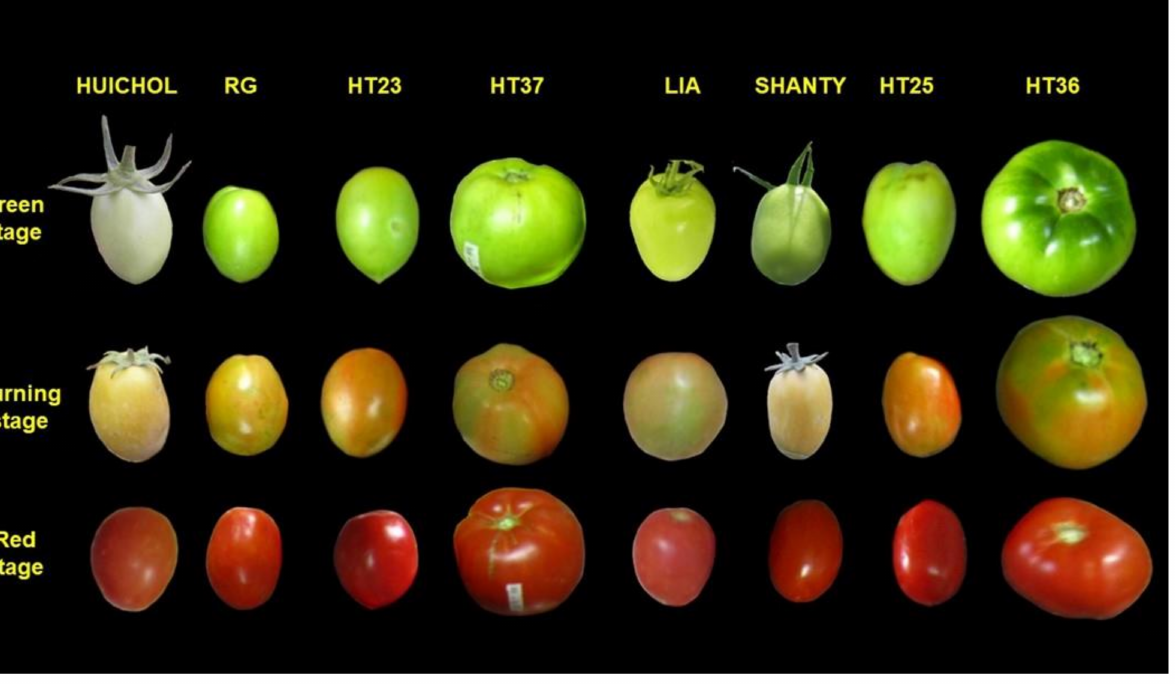
Figure 1. Tomato fruits of eight genotypes (From left to right: ‘Huichol’, ‘Rio Grande’ (RG), ‘HT23’, ‘HT37’, ‘Lia’, ‘Shanty’, ‘HT25’ and ‘HT36’) at three maturity stages (green, turning and